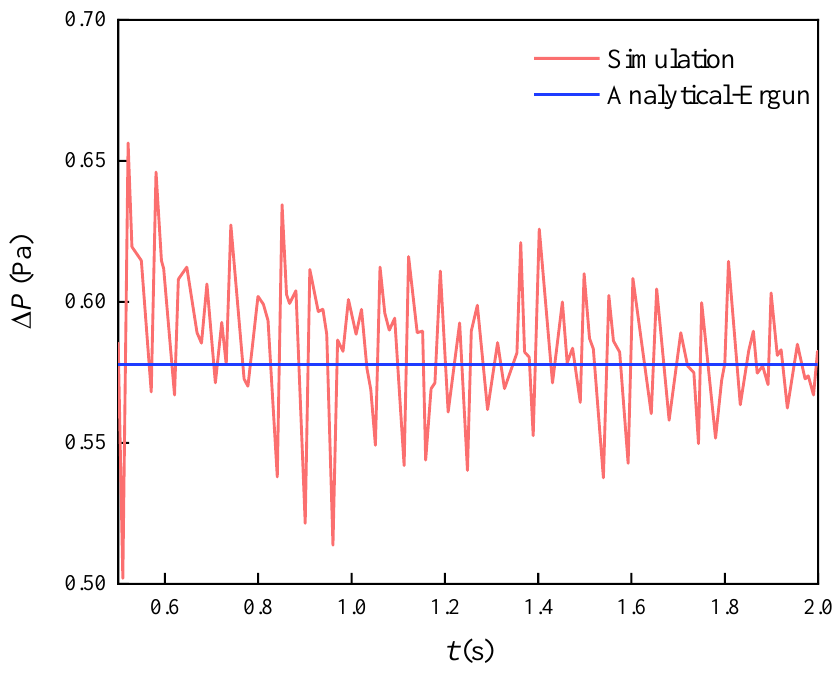
Figure 5. Comparison of pressure drop with time from simulation and Ergun equation at d p = 0.14 m. Figure 6 illustrates the variation of the pressure drop for different particle diameters. The packed bed ’s pressure drop decreases with increasing particle size, and the simulated values follow the same trend as the pressure drop curve obtained from the classical Ergun equation calculation.